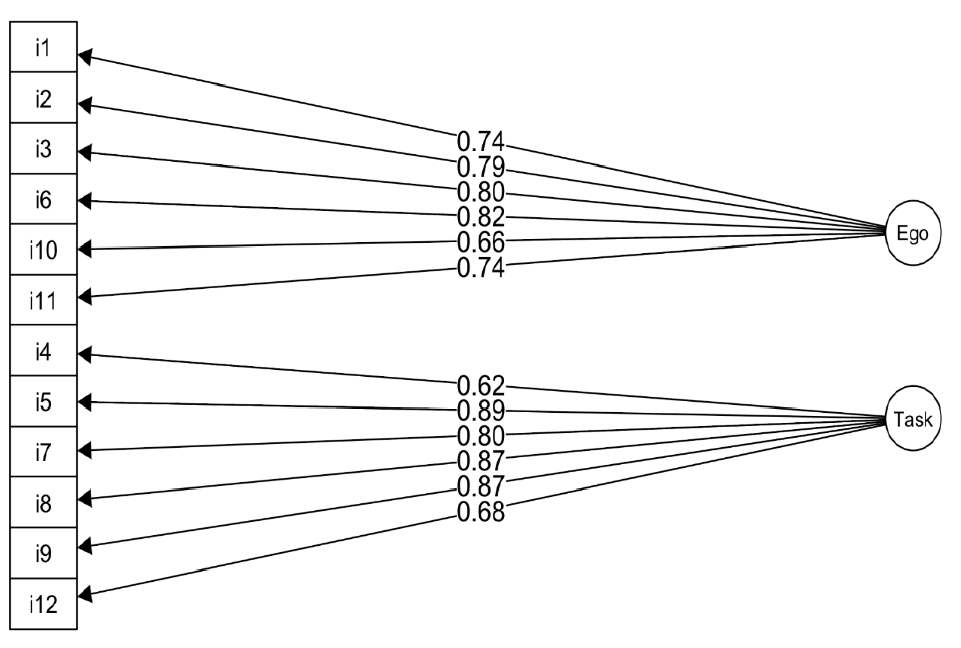
Figure 5. Factors ego and task of the POSQ model: Chi2(54) = 226.86, p < 0.001, CFI = 0.942, TLI = 0.929, NFI = 0.926, RMSEA = 0.088 CI.90